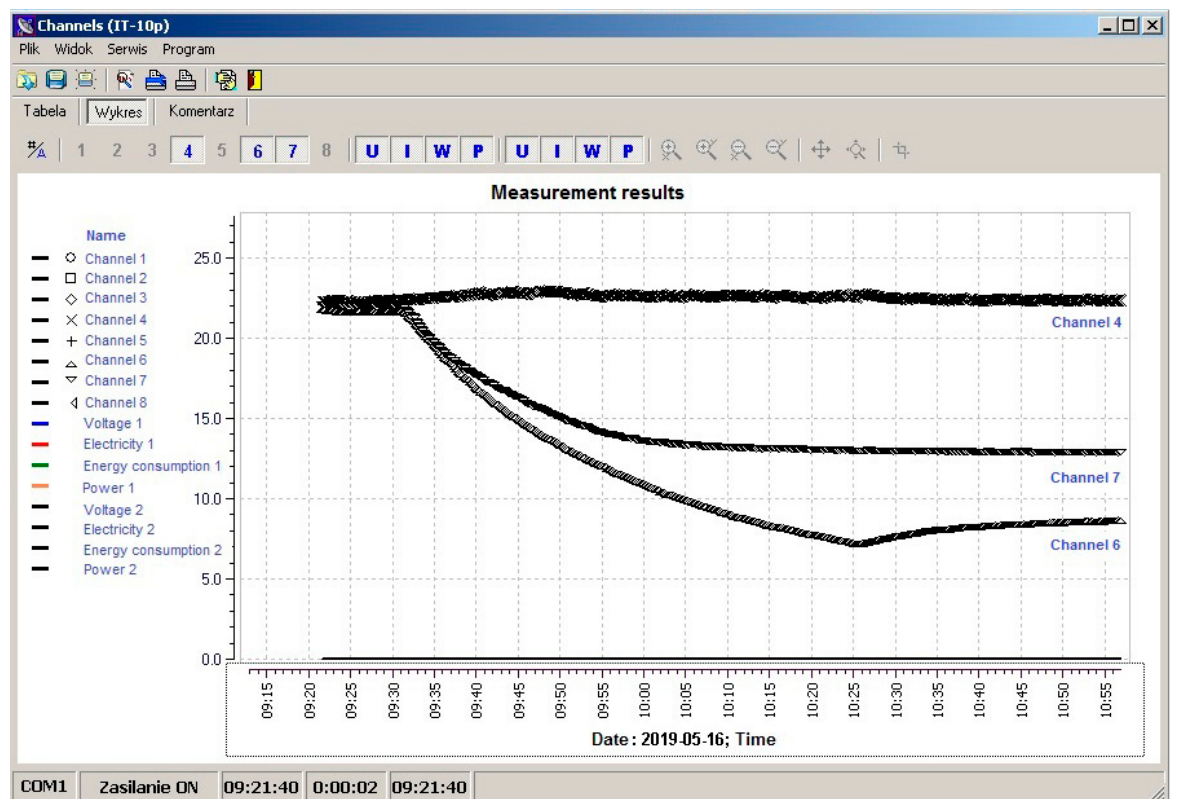
Figure 4. The course of the ambient temperature (x channel 4) and the temperature in the geometric center of the chamber during comparative analysis of the Electroline ( (cid:53) channel 7) and ChTT-48 ( (cid:52) channel 6) refrigerators. Table 3. Determined overall k coefficient of thermoelectric refrigerators of different manufacturers at ambient temperature of 22 ◦ C and the heater heating power 17.4